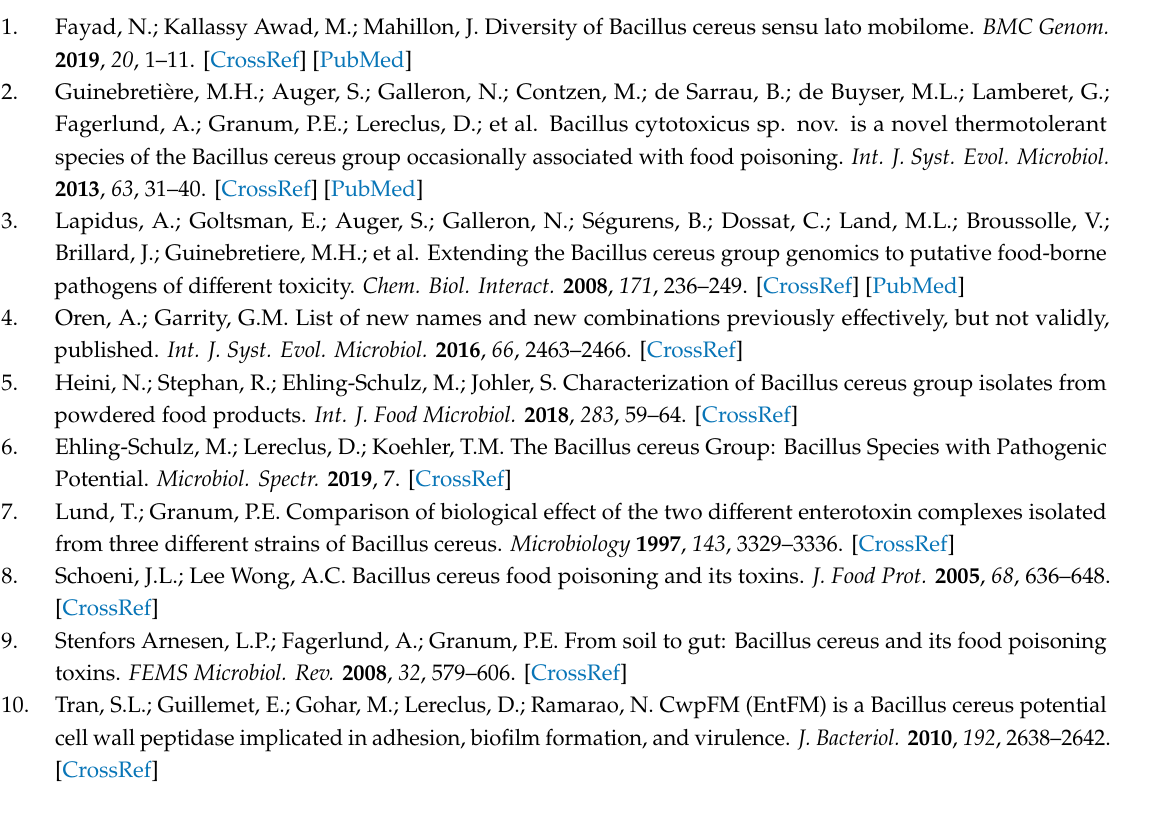
Table S1: B. cereus ’s maximum growth rate (log.conc / h), double time (hours), maximum population density (MPD; log CFU / g) and lag time (hours) estimated through ComBase predictor software (www.combase.cc) from an initial contamination level of 2 Log CFU / g and 3 Log CFU / g in water bu ff alo mozzarella cheese (with a pH 5.7 and an a w 0.997) at three temperature (15, 18 and 22 ◦ C